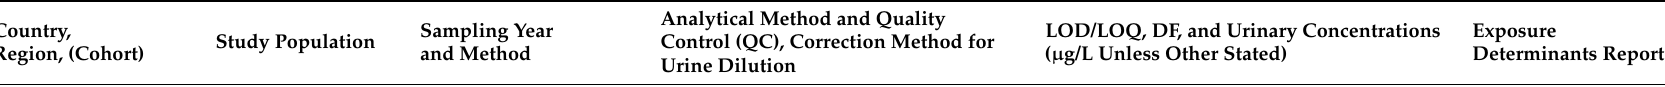
Table 2. Human biomonitoring studies of pyrethroid exposure based on urine samples from European